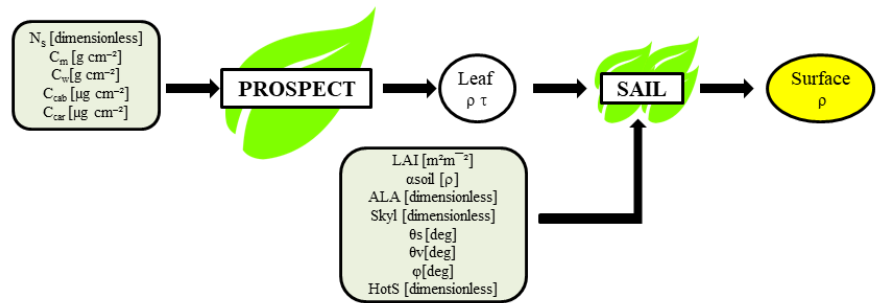
Figure 1. Conceptual diagram of PRO4SAIL forward use. The input parameters are listed in the light green boxes with the respective units. The leaf biophysical acronyms definitions: internal leaf structure ( N s ), dry matter content ( C m ), water content ( C w ), chlorophyll content ( C cab ), and carotenoid content ( C car ). PROSPECT produces leaf reflectance ( ρ ) and transmittance ( τ ) which are used as inputs in SAIL, along with the SAIL canopy architectural inputs: leaf area index ( LAI ), a soil reflectance scale parameter ( αsoil ), average leaf angle ( ALA ), fraction of diffuse incoming solar radiation ( skyl ), sun zenith angle ( θ s ), sensor viewing angle ( θ v ), relative azimuth angle between the sensor and sun ( φ ), and the hot-spot size parameter ( HotS ) to produce an estimated bidirectional surface reflectance ( surface ρ ).